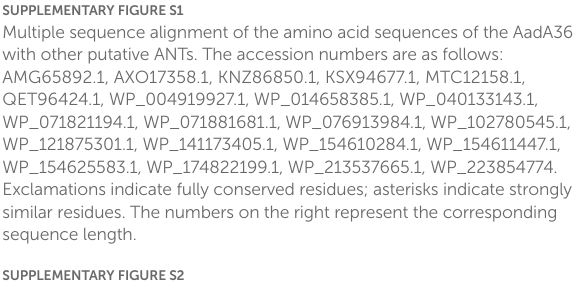
SUPPLEMENTARY FIGURE S3 SDS-PAGE of AadA36. Lane 1: PageRuler Prestained Protein